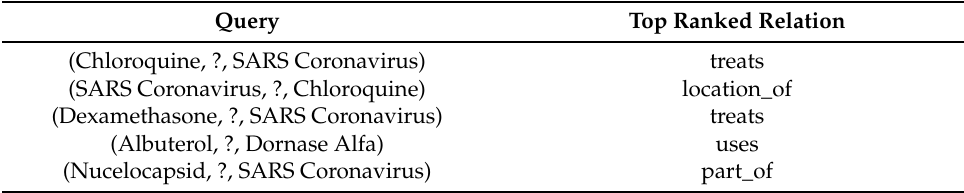
Table 3. Example results from the Relation prediction API with 5 different queries.